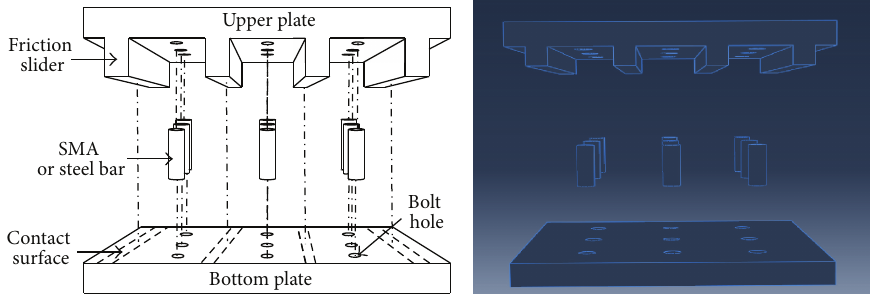
Figure 3: 3D schematic drawing for bearing